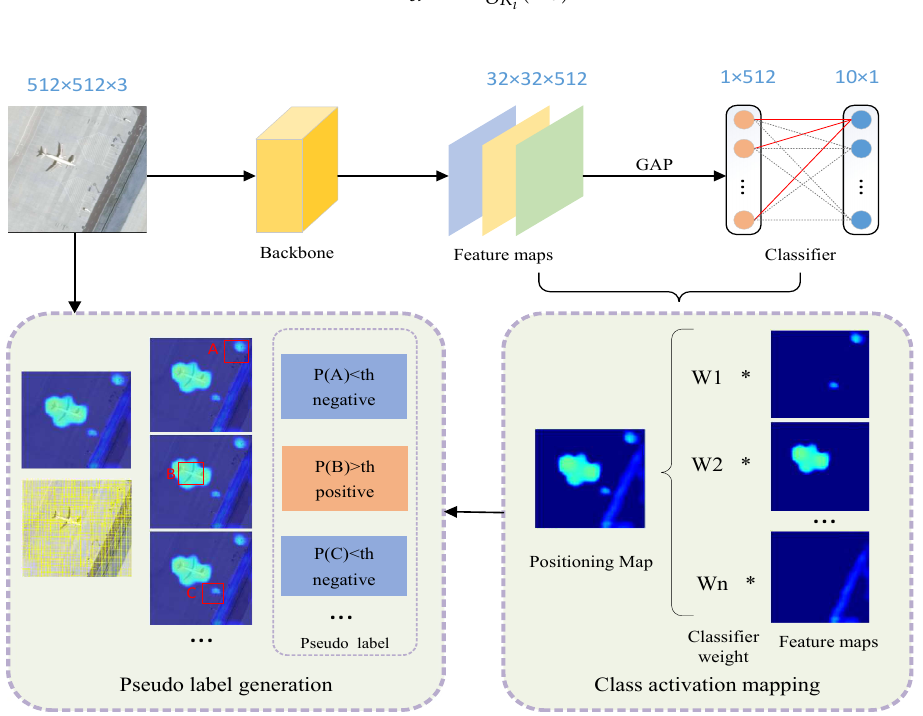
Figure 3. Illustration of the process of pseudo-label generation. For the classification model, the global average pooling layer is trained instead of the fully connected layer. Class activation mapping uses the feature map of the backbone network and the corresponding multiplication of the weights of the classifiers to obtain the localization map of the object. Pseudo-label generation calculates pseudo- labels and confidence scores based on the intersection between the proposal and the localization